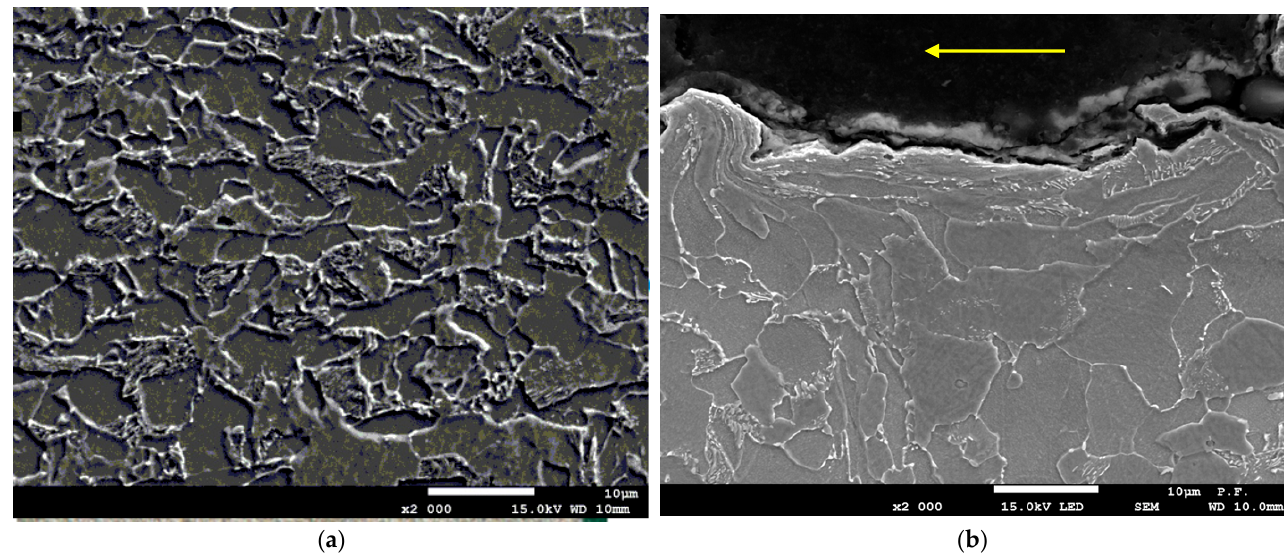
Figure 5. Metallographic cross-section revealing the microstructure of ( a ) the base metal, ( b ) the material cut at a medium-power density of the jet (a pressure of 340 MPa and a cutting speed of 300 mm/min).